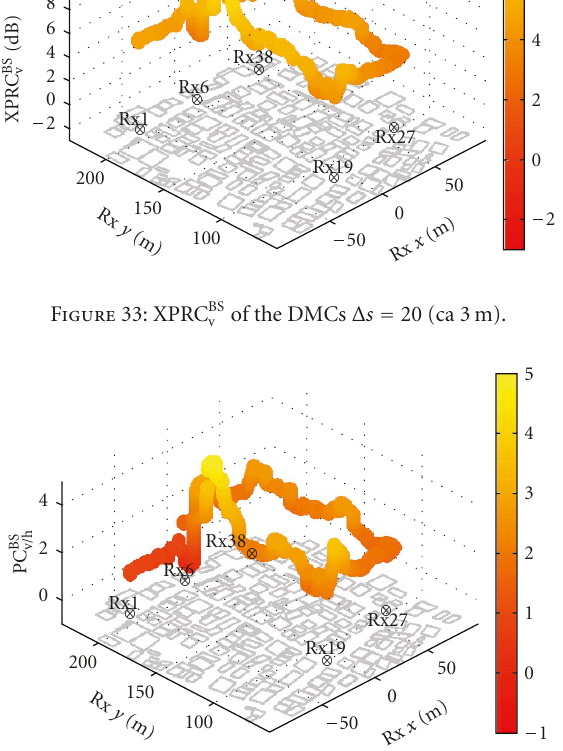
Figure 31: PC MS of the DMCs Δ s = 20 (ca 3 m). v/h